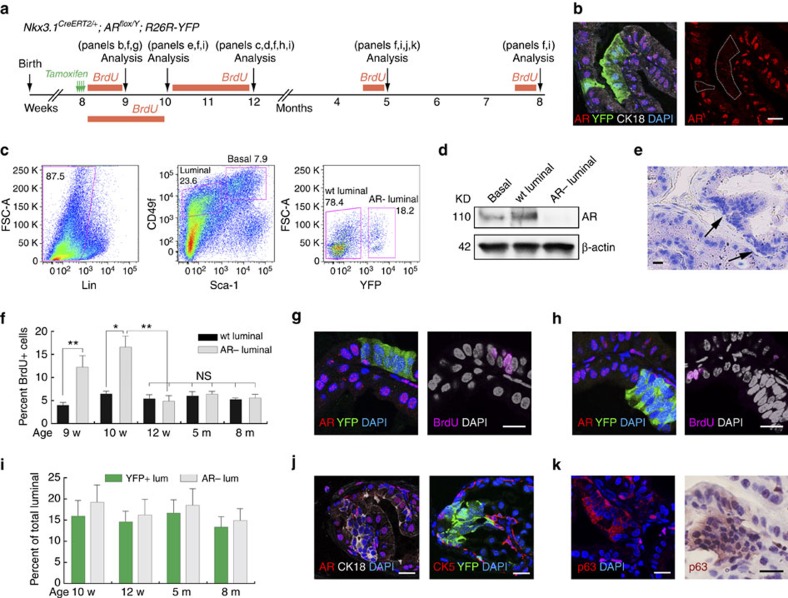
AR loss in luminal cells induces a transient over-proliferation and alters cell morphology.(a) Lineage-tracing strategy in prostate homeostasis of LumYFP,AR− mice. (b) Representative IF staining image showing simultaneous deletion of AR and marking by YFP in luminal cells at 1 week post induction. (c) FACS plot showing the gate drawn for obtaining basal, wild-type luminal and AR− luminal cells from induced LumYFP,AR− mice. (d) Western blot of AR protein from flow-sorted cell populations. (e) H&E staining showing clusters of compact cells (arrows) at 2 weeks post induction. (f) Quantitation of wild-type and AR− luminal cell proliferation rates using BrdU incorporation assays shown in a, showing a transient (1–2 weeks) over-proliferation in AR− luminal cells. *P<0.01, **P<0.001 by t-test. (g,h) Representative IF staining images showing many AR− luminal cells were BrdU+ at 1 week post induction (g) and relatively few were BrdU+ at 4 weeks post induction (h). (i) Quantitation of the percentage of YFP+ or AR− luminal cells during homeostasis showing no significant difference by t-test for different time points since 2 weeks post induction. (j) IF staining of tissues at 3 months post induction showing enhanced CK18 expression (left) and no detectable CK5 expression (right) in AR−/YFP+ luminal cell clusters. (k) Cytoplasmic p63 expression was enhanced in AR− luminal cell clusters by both IF (left) and IHC (right) staining using two antibodies. Scale bars correspond to 20 μm. Error bars correspond to one s.d.